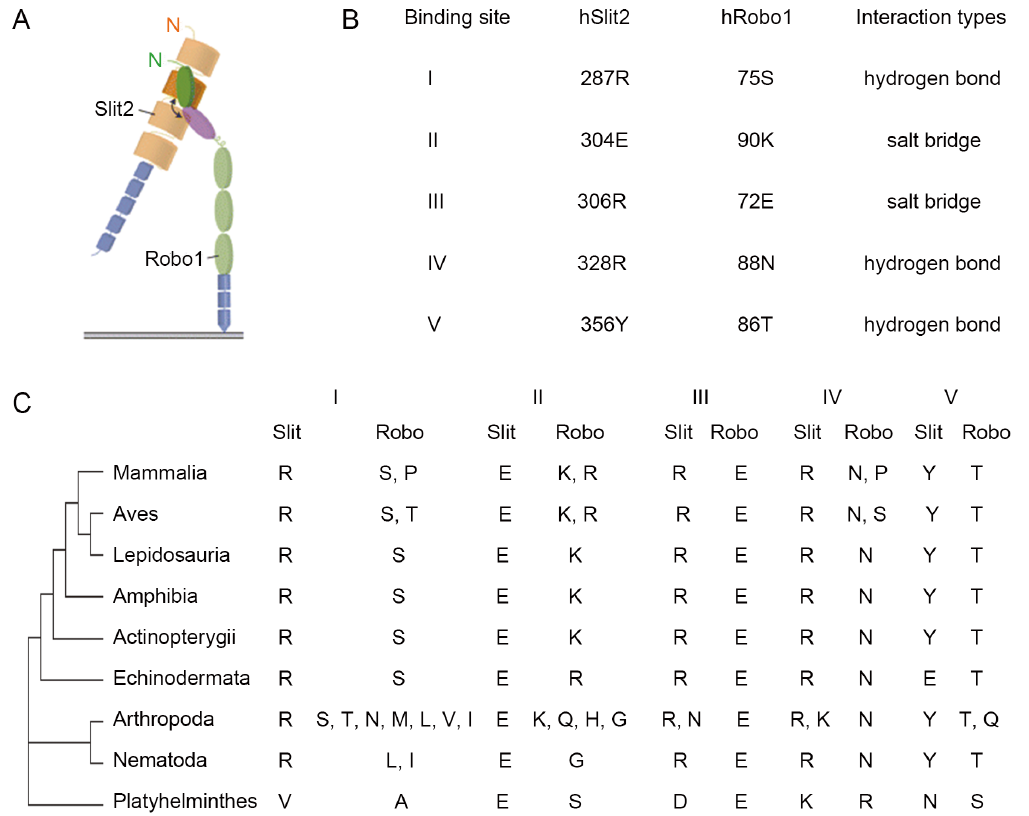
Figure 1. Analysis of interacting amino acids between Slit and Robo. (A) A schematic presentation of the interaction between hSlit2 and hRobo1 through LRR2 domain (orange) bound to Ig1 domain (green) [20]. (B) The binding sites of hSlit2 and hRobo1 identified by SPR spectroscopy [20]. (C) Phylogenetic distribution of interacting amino acids of Slit and Robo. doi:10.1371/journal.pone.0094970.g001 classified into three types. The first type of change is that the paired interacting amino acids are conserved in Slit while changed in Robo. In this type, the interaction between basic amino acid and hydrophobic amino acid of R-L changed to R-S which is between basic amino acid and neutral amino acid. Similarly, the interaction between acidic amino acid and neutral amino acid of E-S changed to E-G which is between acidic amino acid and neutral amino acid. This type of changes can not affect the interaction between Slit and Robo. The second type of change is that the paired interacting amino acids are conserved in Robo while changed in Slit. In this type, the interaction between neutral amino acids of Y-T changed to E-T which is between acid amino acid and neutral amino acid, which also has no effect on their interaction. Both Slit and Robo are changed in the third type. In